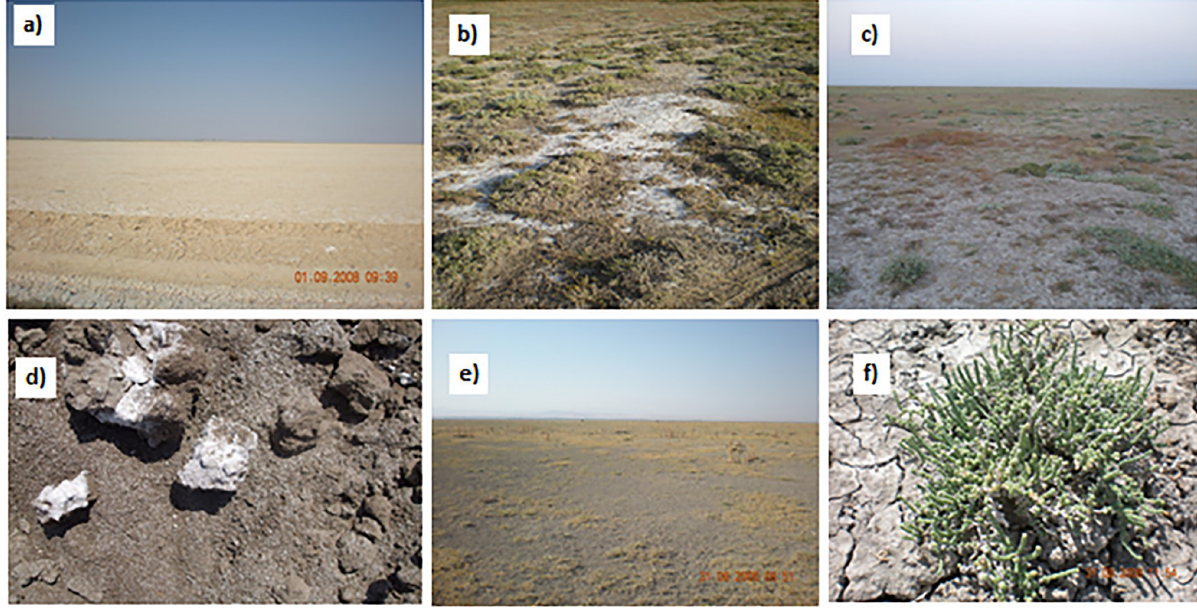
Fig 2. Saline areas with bare surfaces (a and b), area covered with salt crusts and halophytes (c), salt crystals on the surface and soil profile (d), surface with dried vegetation (e) and a sample halophyte plant (f). (Pictures taken by Mesut